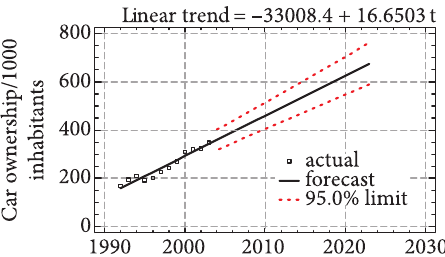
fig. 7. The forecast of car ownership level in Vilnius (veh./1000